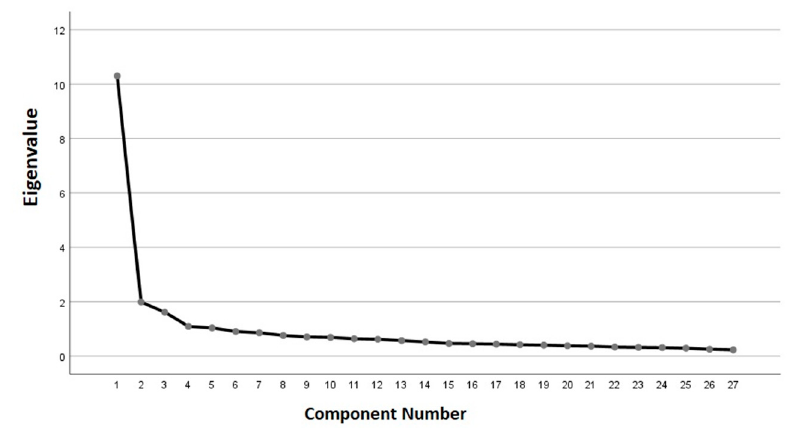
Figure 1. Sedimentation graph for the exploratory factor analysis.